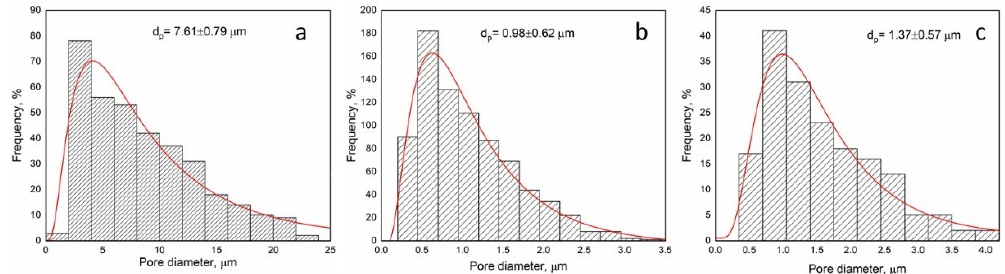
Figure 3. Pore Diameter Distribution of PHB + Curc membrane ( a ); PCL + Curc membrane ( b ); ( c ) PCL/PHB/Curc membrane.